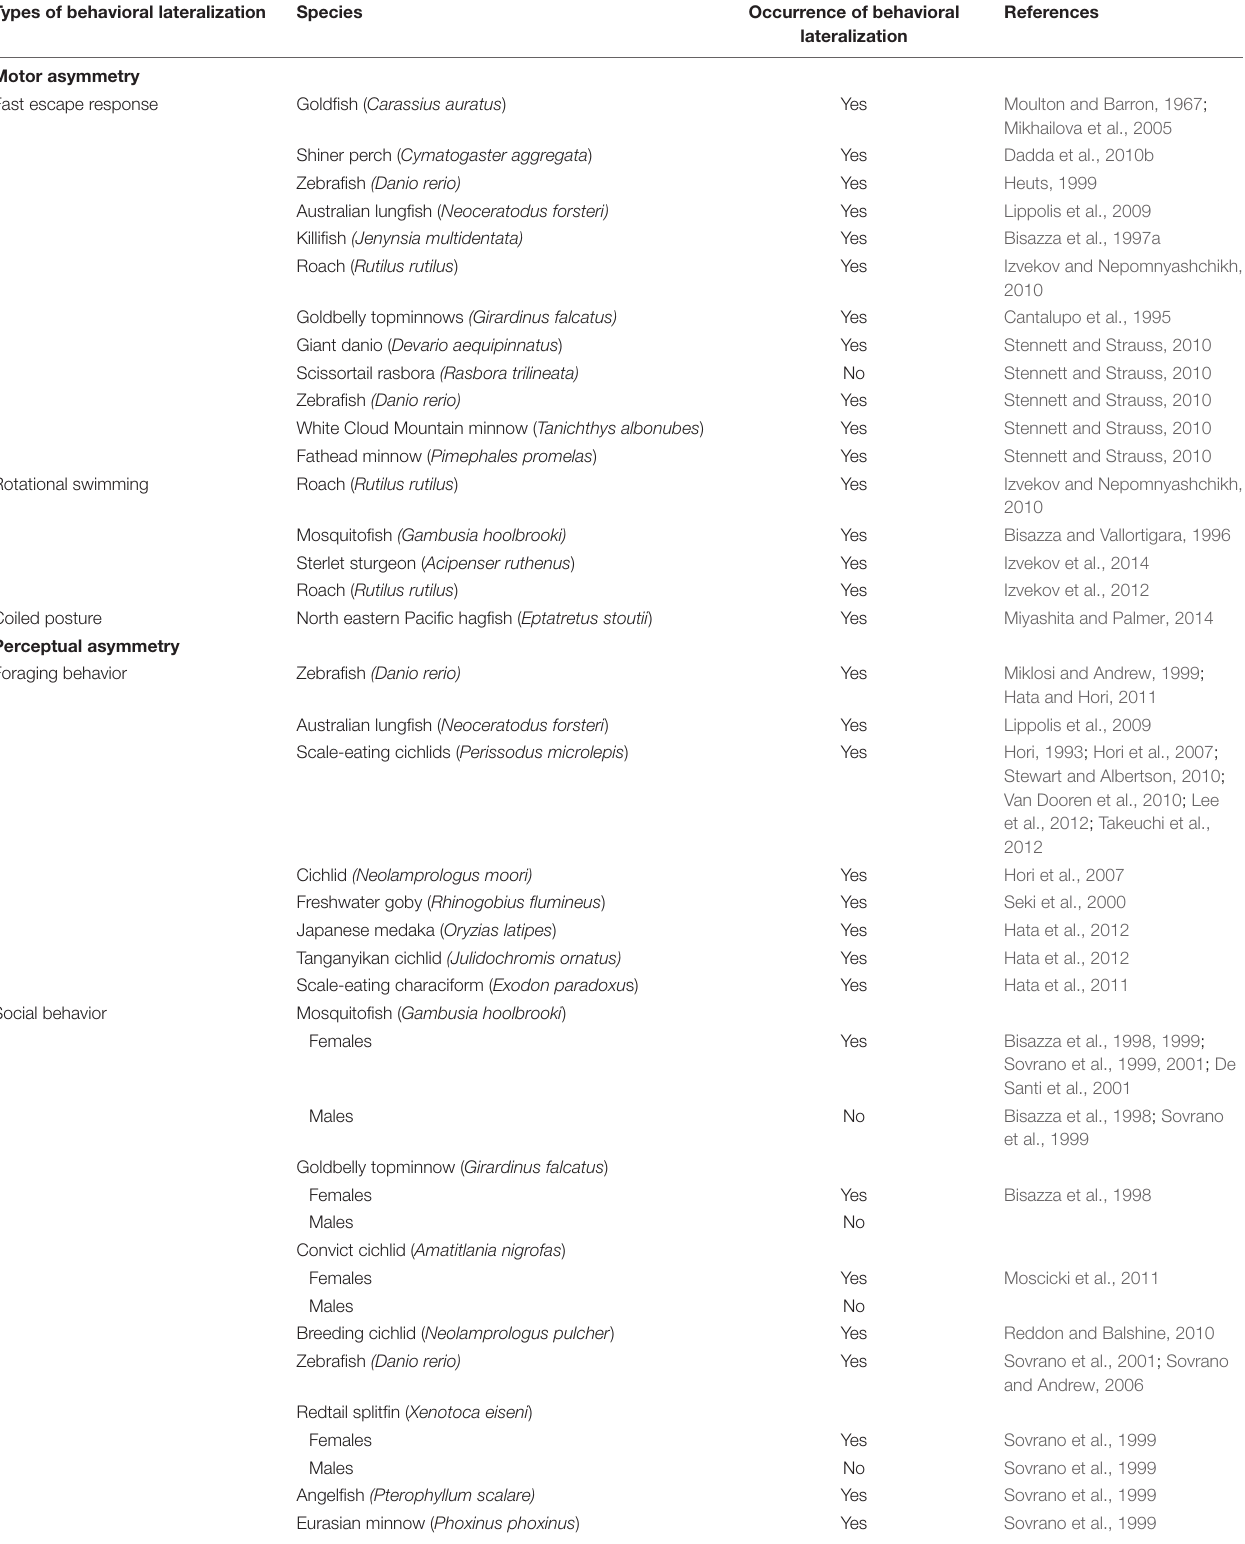
TABLE 1 | Types of behavioral lateralization investigated and species in which lateralization has been observed or